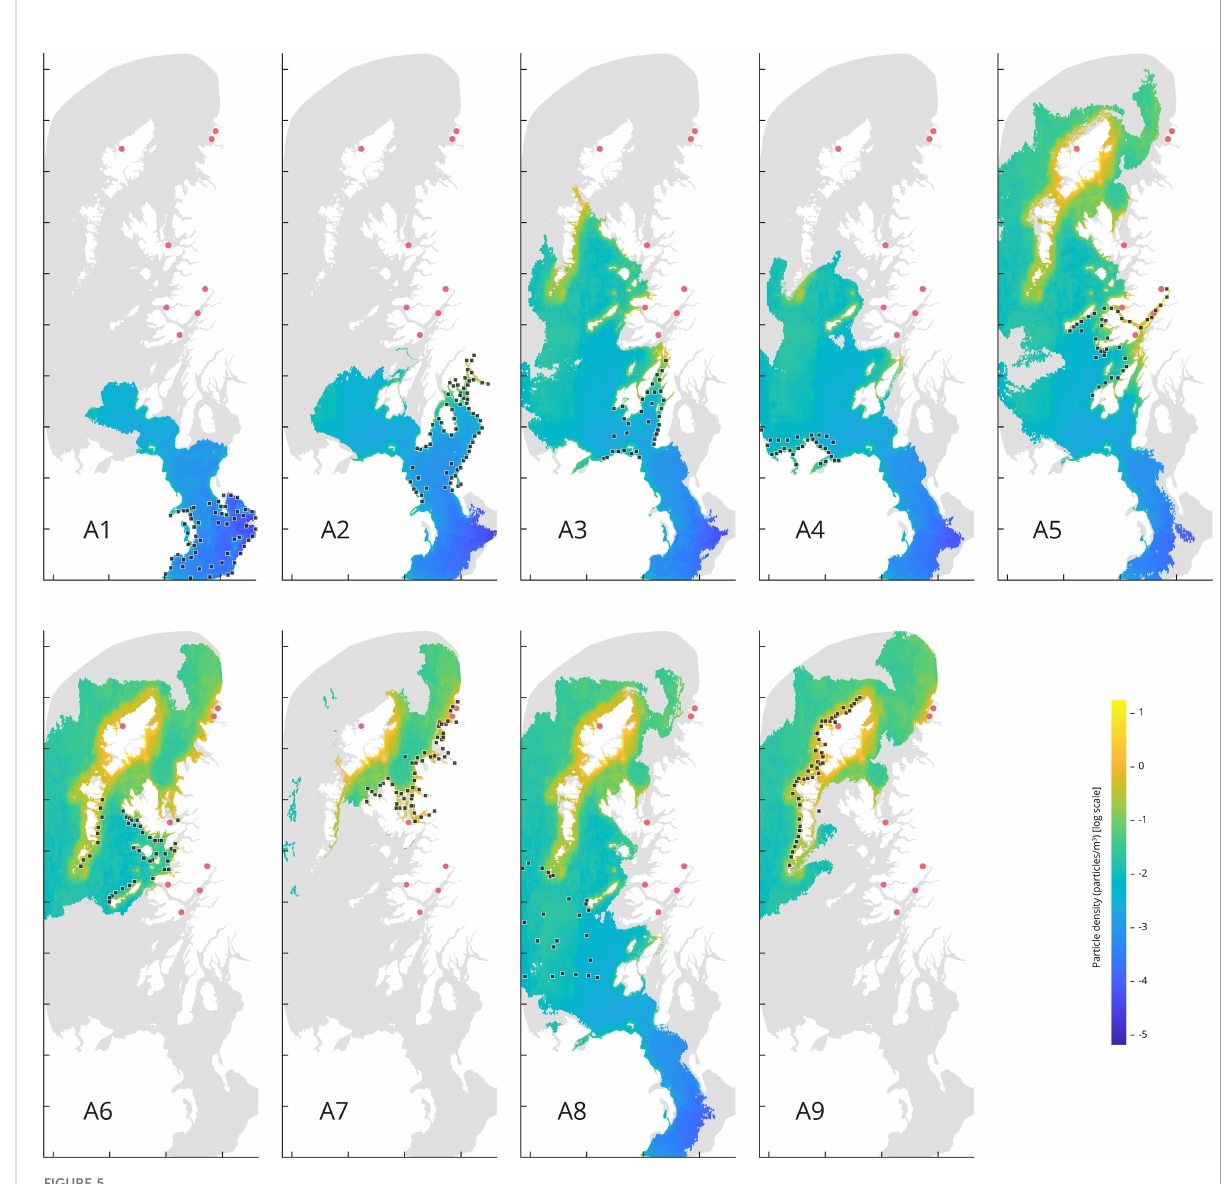
FIGURE 5 Particle density (particles/m 3 ) from particles released from each source area. the map depicts the period from 27 th April to 3 rd May 2021, at a depth of 6 m. Tidal cycle releases simulation set up (continuous release for the fi rst 14 days). The red dots represent the eight target sites. Each source points from the area A1 through A9 are represented by a black